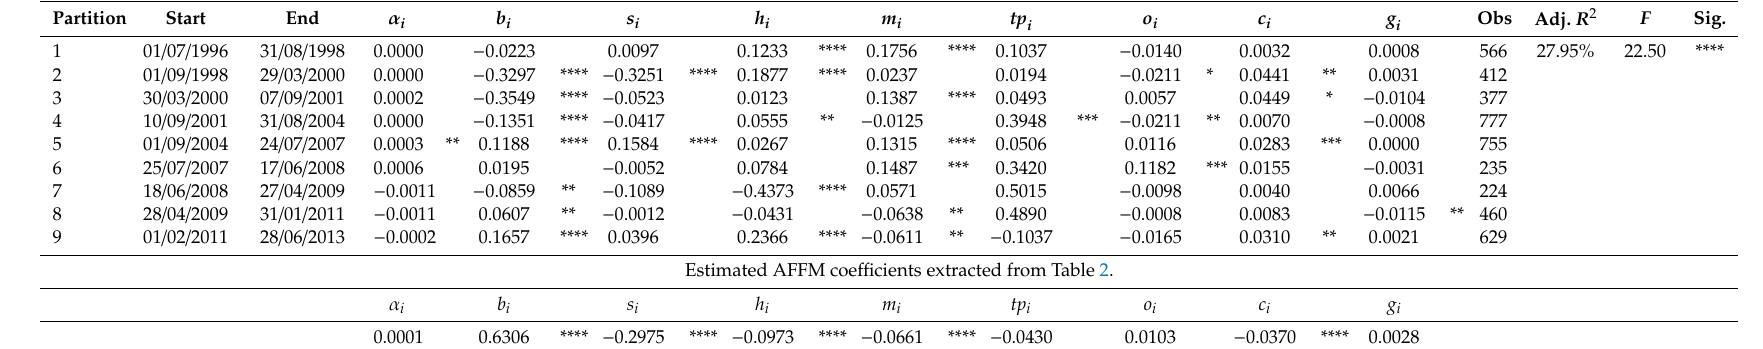
Table 7. Second-pass sequential breakpoint test on